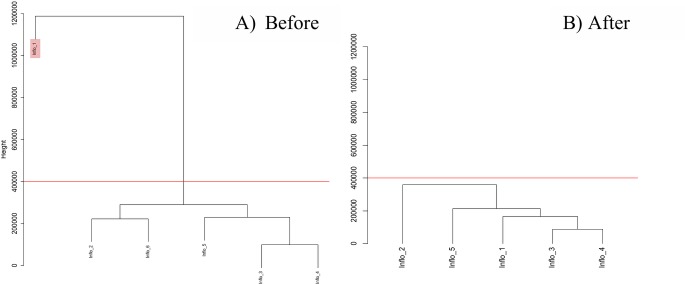
Detection for Jatropha curcas (inflorescence) outlier samples.A) Cluster of dendrogram indicates presence of an outlier (red box) above the cut-off height = 400 000. B) After the removal of an outlier, the dendrogram of cluster indicates homogeneity among the samples below the cut-off height.